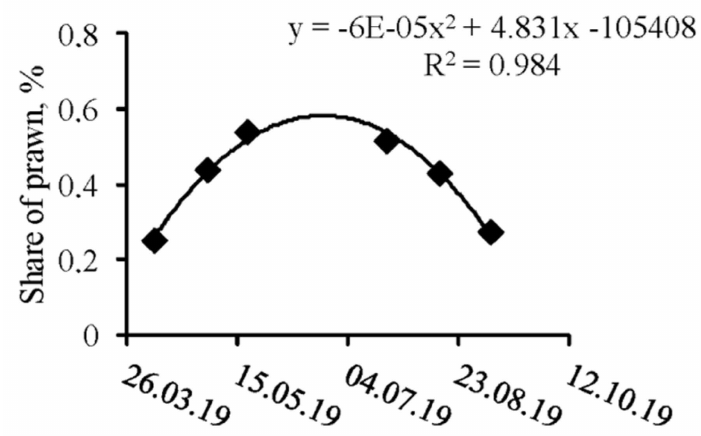
Figure 4. Change the share of Palaemon adspersus females with eggs from their total number in the hypersaline Lake Moynaki in 2019.